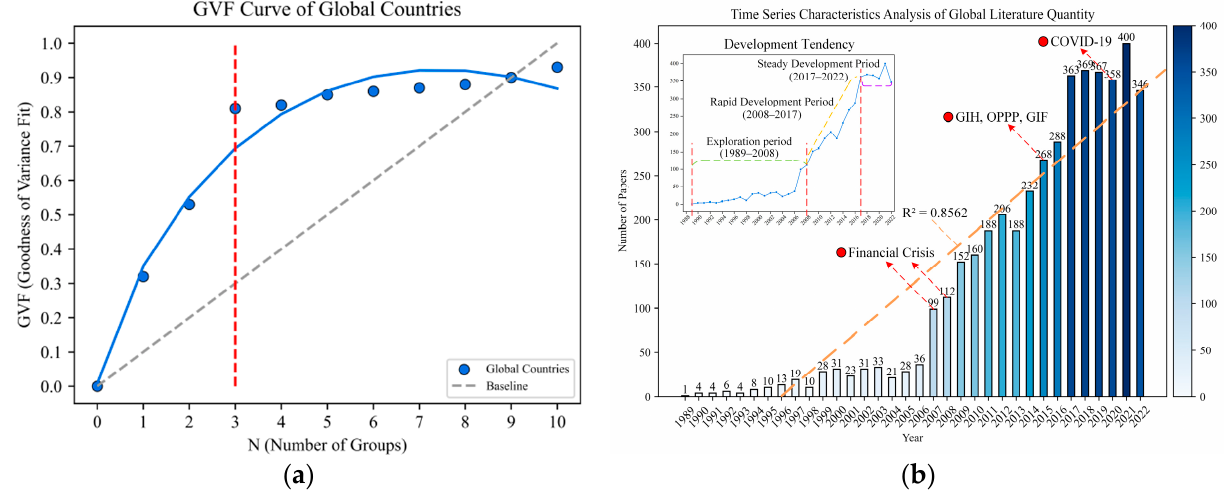
Figure 2. Global Bibliometric Comparison and GVF Test ( a ) GVF Curve of Global Countries; ( b ) Time Series Characteristics Analysis of Global Literature Quantity.